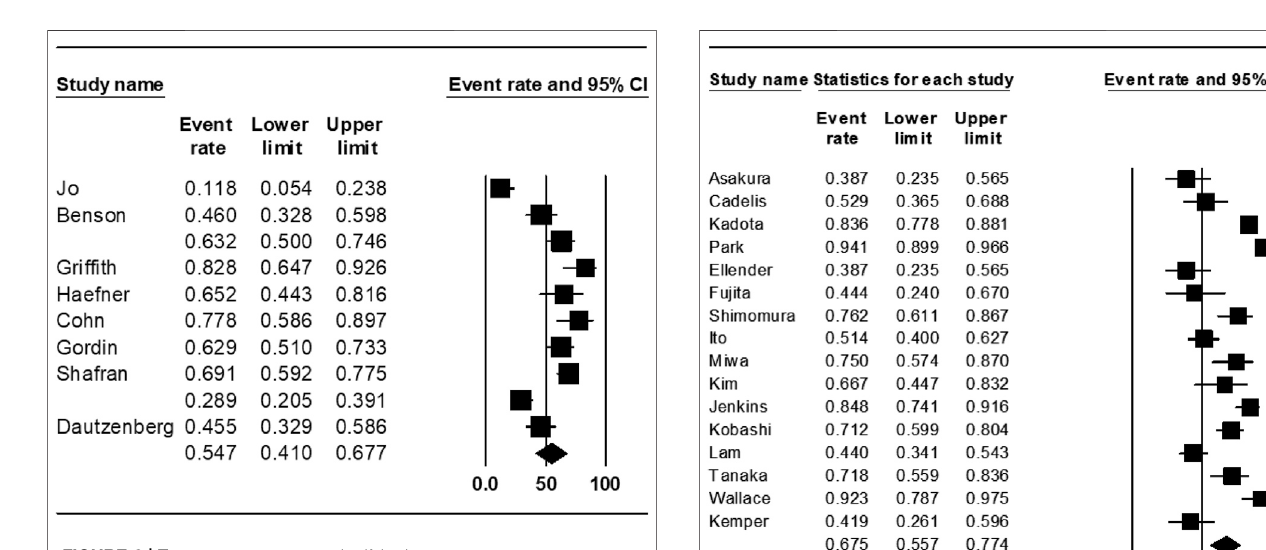
FIGURE 2 | Treatment success rate in rifabutin group.